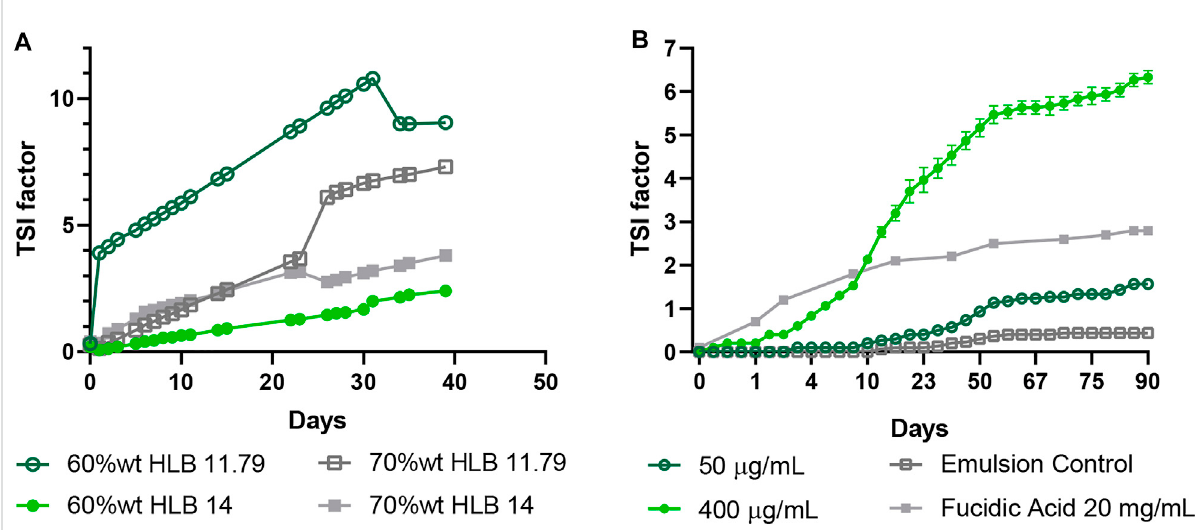
FIGURE 2 Time evolution of the stability index for bare O/W emulsions as measured in the Turbiscan instrument. (A) Emulsions at 60% wt., 70% wt. and, HLB of 11.79 and 14 analyzed for 39 days. (B) Emulsions were prepared with the MNPs-PEG8-BUF-II-Ag nanobioconjugates (50 μ g/ml and 400 μ g/ ml) at 60% wt. and HLB 14. The emulsions were analyzed for 90 days after